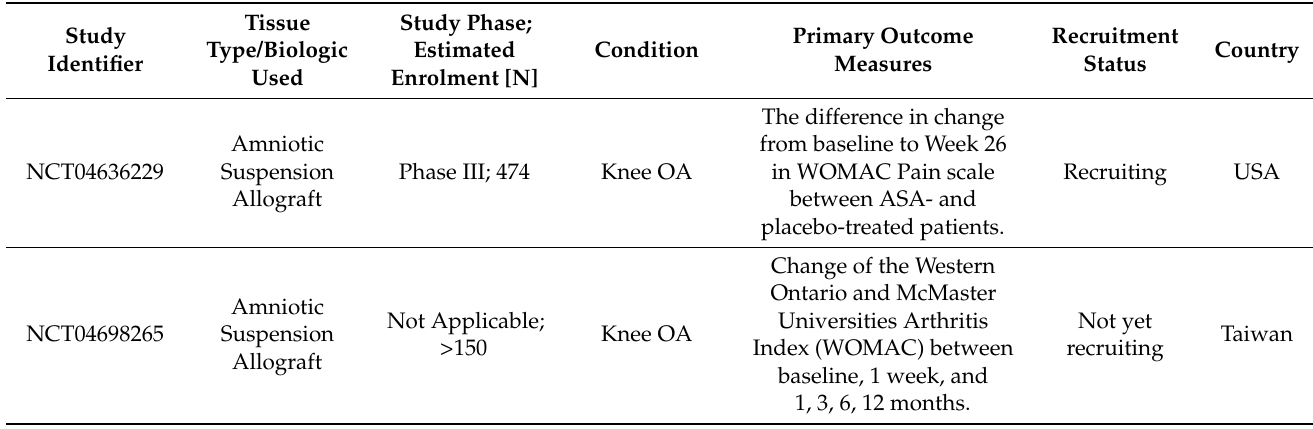
Table 2. Clinical trials registered on ClinicalTrials.gov till 10 October 2022 utilizing amniotic suspen- sion allografts for the treatment of orthopedic